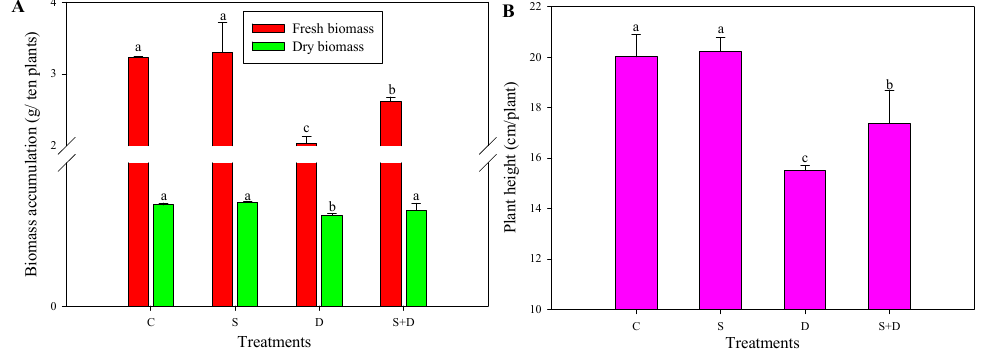
Figure 2. Phenotypic ( A , B ) changes in leaves of wheat seedlings under normal water conditions and in response to three different treatments; a total of three independent biological replicates were used ( n = 10). For a detailed description of treatment conditions, please refer to the legend of Figure 1. Different lowercase letters indicate a statistically significant difference at p < 0.05.